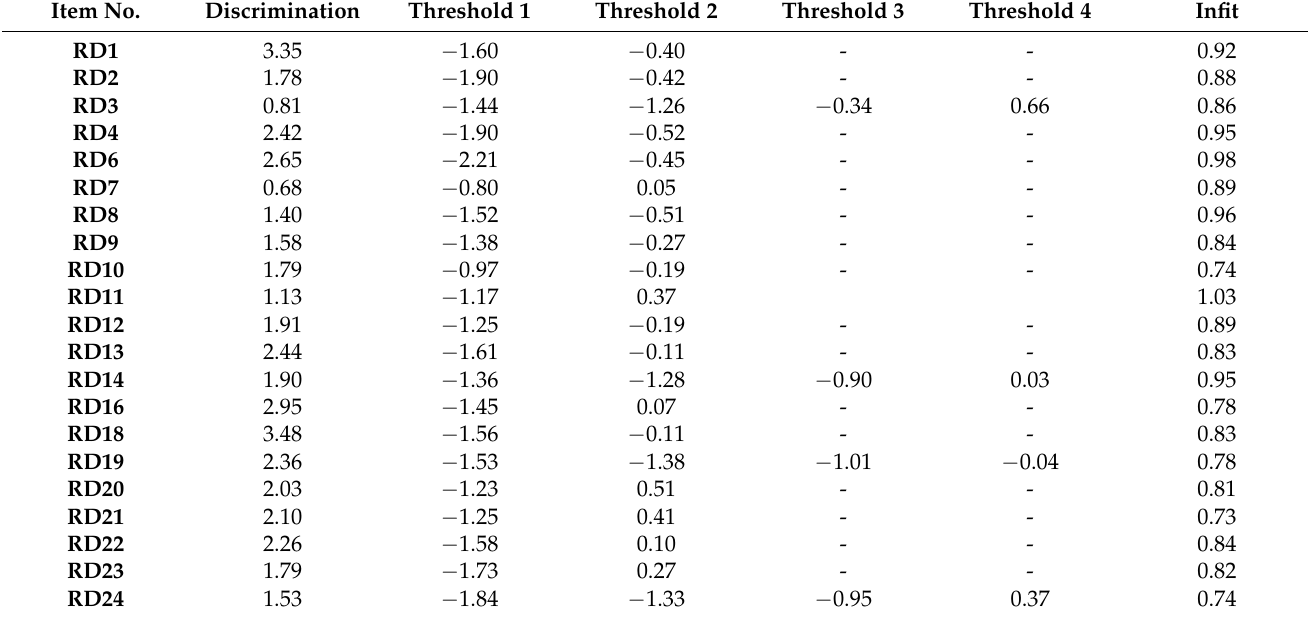
Table A1. Parameter estimates (discrimination and thresholds) and fit statistics for the 21 items in the final PREMIUM-RD item bank.